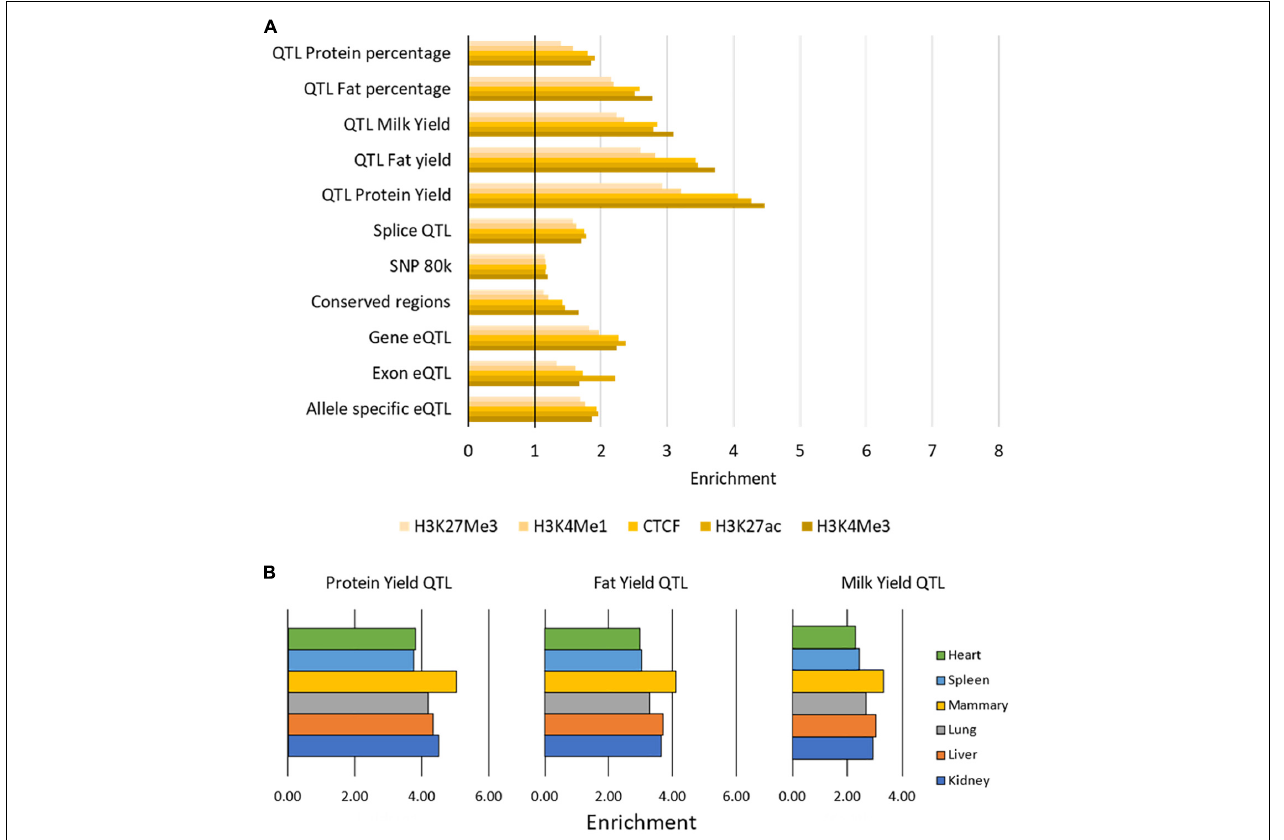
FIGURE 6 | Enrichment of causal variants within functional regions. (A) Enrichment of causal variants within peaks. Enrichment of each SNP dataset within each histone modification or CTCF averaged across tissues. All values above 1 (indicated by the vertical black bar) are enriched for causal variants. Enrichment was significant with P < 0.001 for all tests. (B) Enrichment of three sets of milk trait QTL within H3K27ac peaks. Peaks in mammary gland have the highest enrichment for these milk trait QTL.